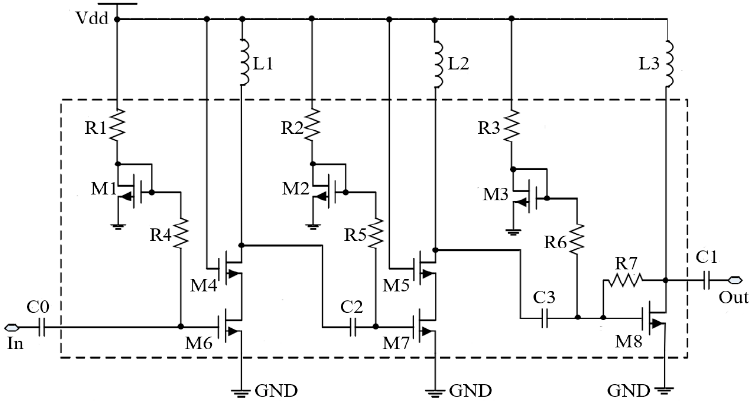
Figure 2. The schematic diagram of 0.1–1.2 GHz Class-A PA.